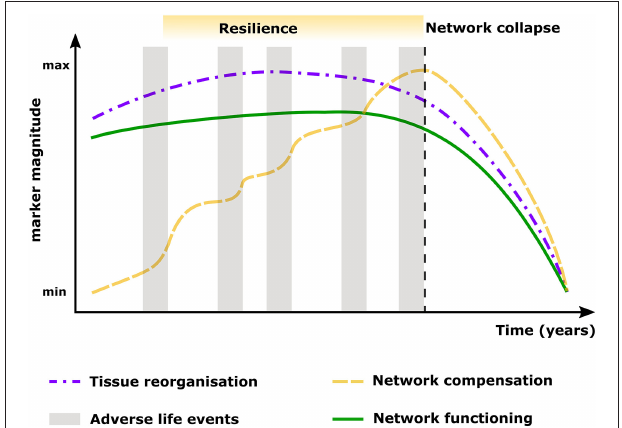
FIGURE 2 | Model showing the likely developmental trends of resilience, showing the maintenance or recovery of mental health during and after exposure to significant adverse event results from a dynamic process of adaptation to the given life circumstances (gray boxes), where global reorganization (purple line) and mechanisms of compensation (yellow line) across the whole brain network are in charge of maintaining optimal functioning and efficiency (green line) in relation to cognitive ability and mental health. However, increased or sustained exposure to adverse life events or inadequate network reorganization will lead to exhaustion or collapse of the network (black dashed line), which manifests as divergent lifespan patterns or breakdown of functional responses leading to loss of mental